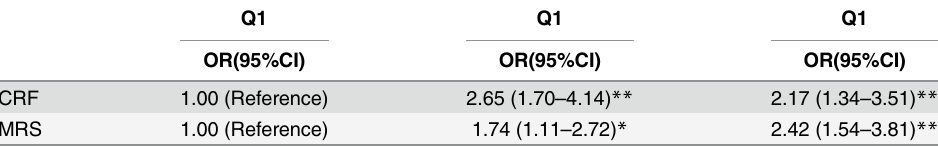
Table 4. Associations between location and decreasing CRF tertiles and increasing MRS